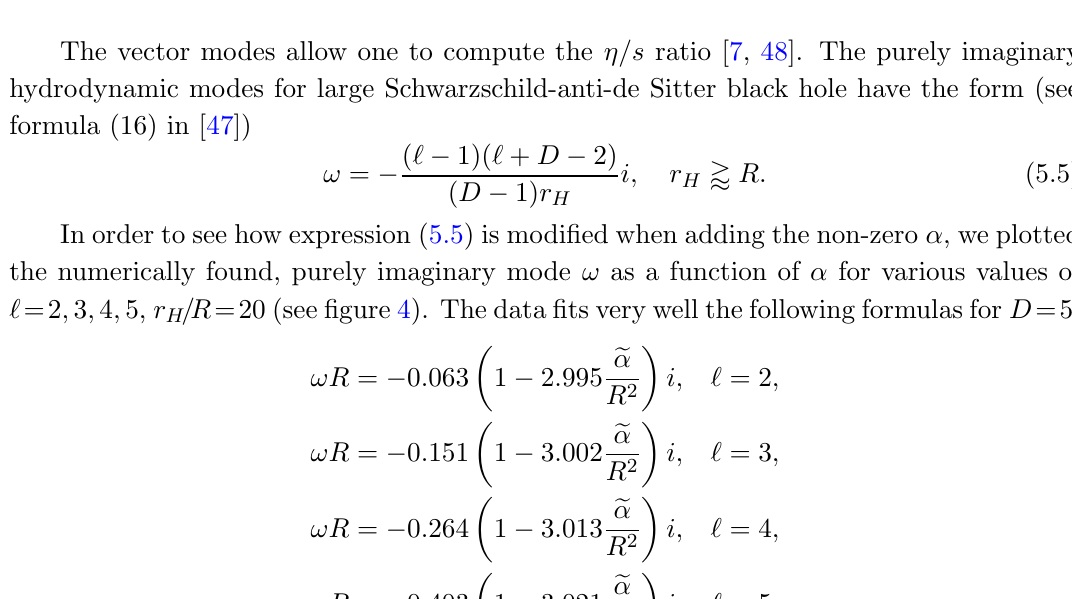
Figure 4 . Purely imaginary vector (shear) mode for D = 5 (left panel) and D = 6 (right panel) as a function of (cid:11) for r H =R = 20: ‘ = 2 (blue), ‘ = 3 (green), ‘ = 4 (red), ‘ = 5 e